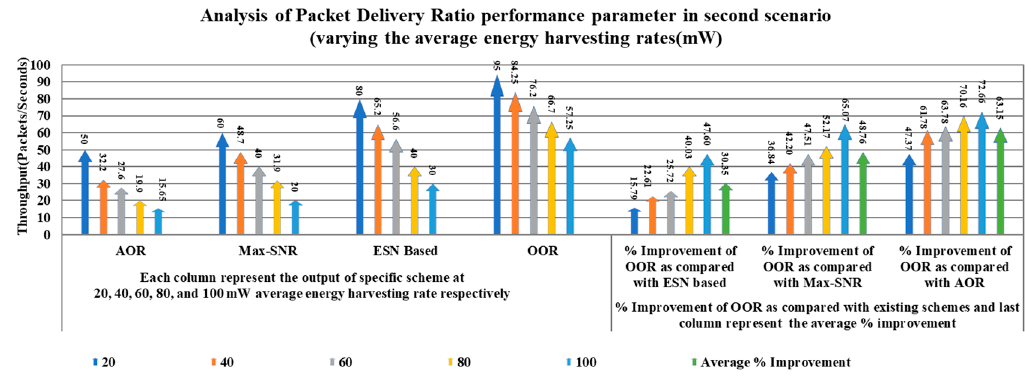
Figure 15. Detailed performance reflection of OOR with throughput parameter (second scenario).